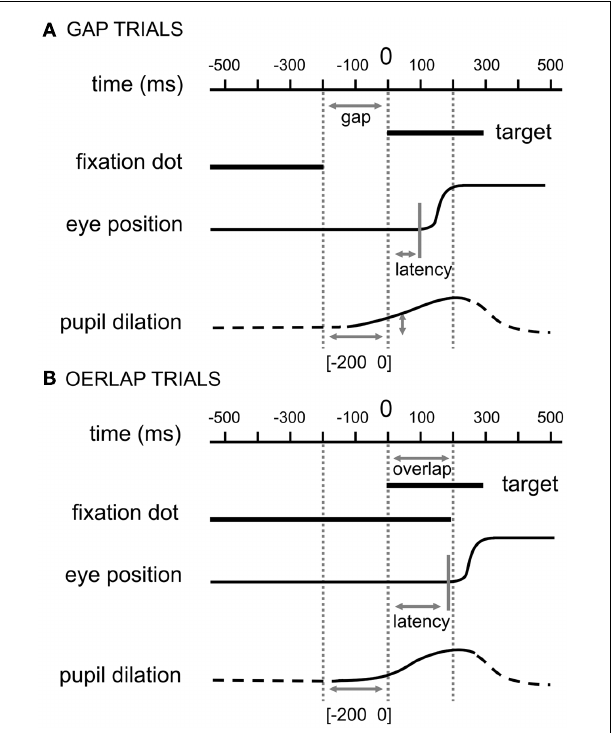
FIGURE 1 | Experimental paradigms. (A) Gap paradigm, the central fixation point disappeared 200ms before the appearance of the eccentric target. (B) Overlap paradigm, the central fixation point remained illuminated for 200ms after the appearance of the eccentric target. In both cases, the latency was the period between the onset of the target and the beginning of the saccade and the pupil dilation was calculated for the corresponding gap period [ − 200 0]. For illustration purpose, we included stereotypical eye movement and pupil response